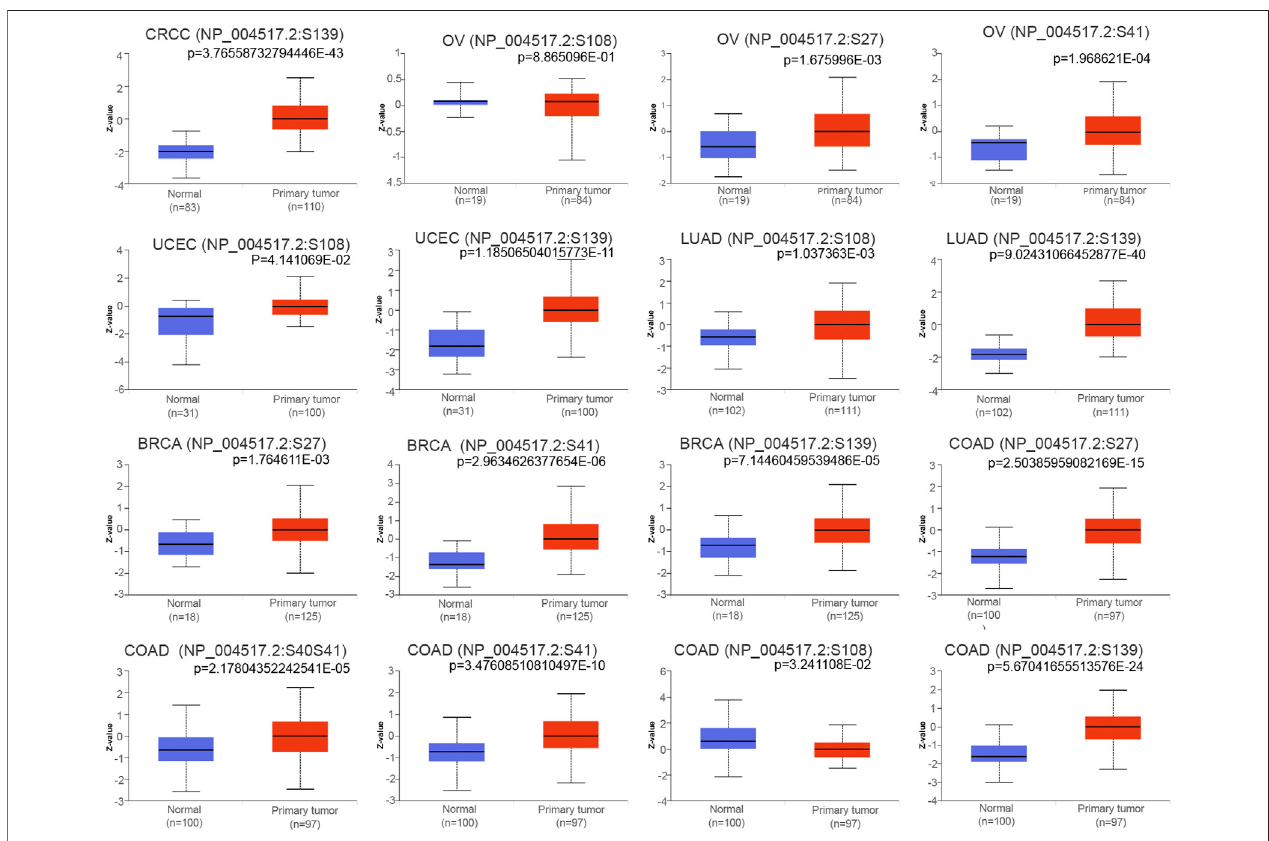
FIGURE 6 | Boxplots showing differential MCM2 phosphorylation levels (beta values) between tumors and adjacent normal tissues across TCGA database.